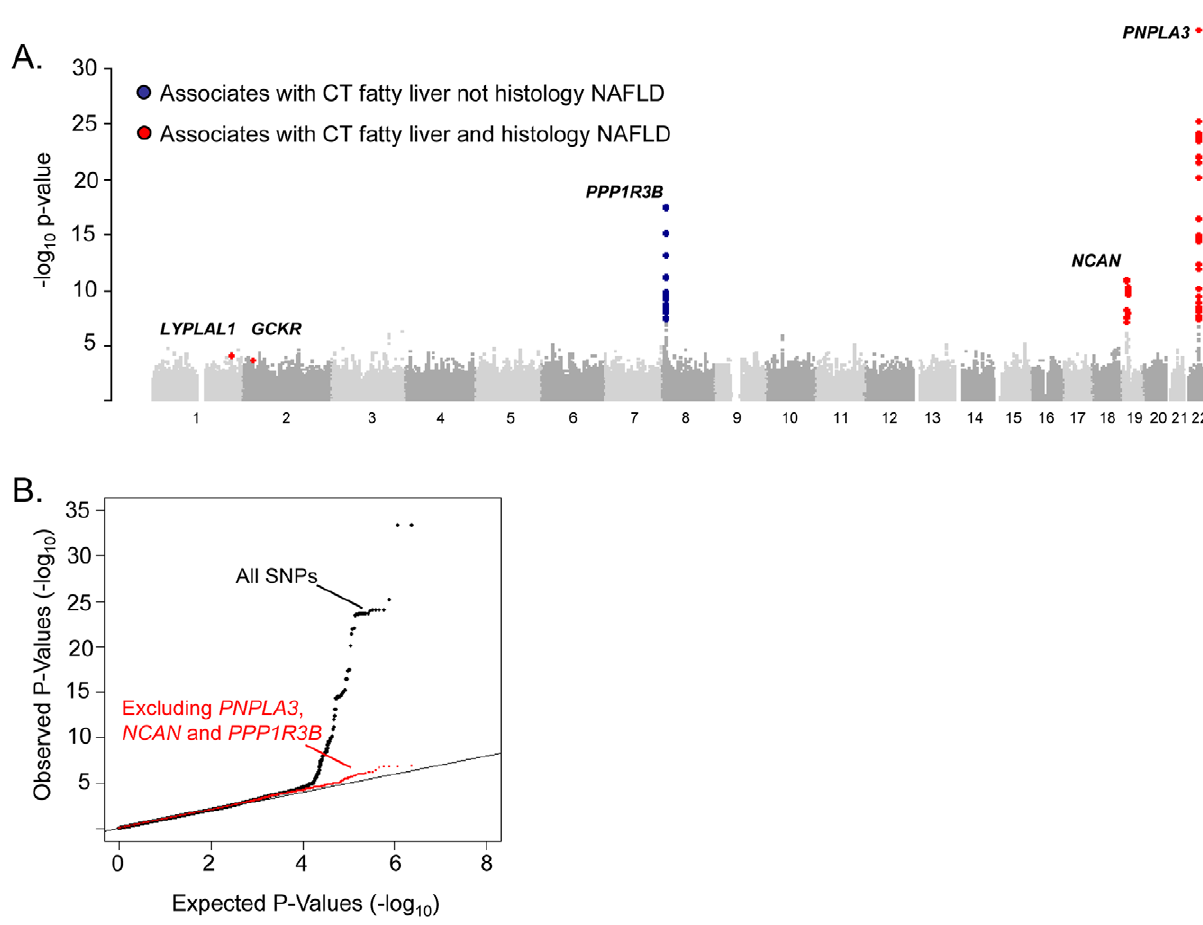
Figure 2. Genome-wide association results for GOLD (Stage 1). A. Manhattan plot showing the significance of association of all SNPs in the Stage 1 GOLD meta-analysis with CT hepatic steatosis. SNPs are plotted on the x-axis according to their position on each chromosome against association with CT hepatic steatosis on the y-axis (shown as -log10 p-value). SNPs that also associate with histology based NAFLD are in red, those that only associate with CT hepatic steatosis in blue. B. Quantile-quantile plot of SNPs after Stage 1 GOLD meta-analysis (black) and after removing any SNPs within 500 kb of PNPLA3, PPP1R3B, and NCAN (red).